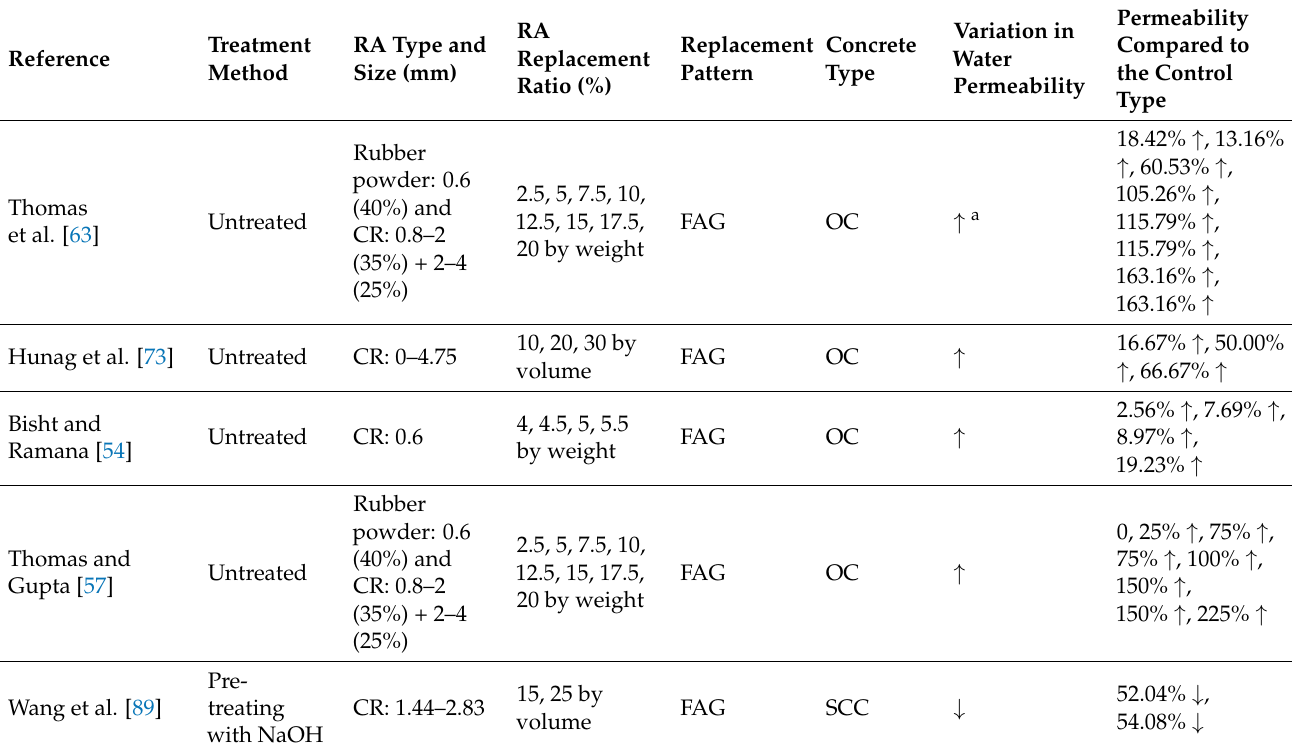
Table 7. Influence of rubber on the concrete water